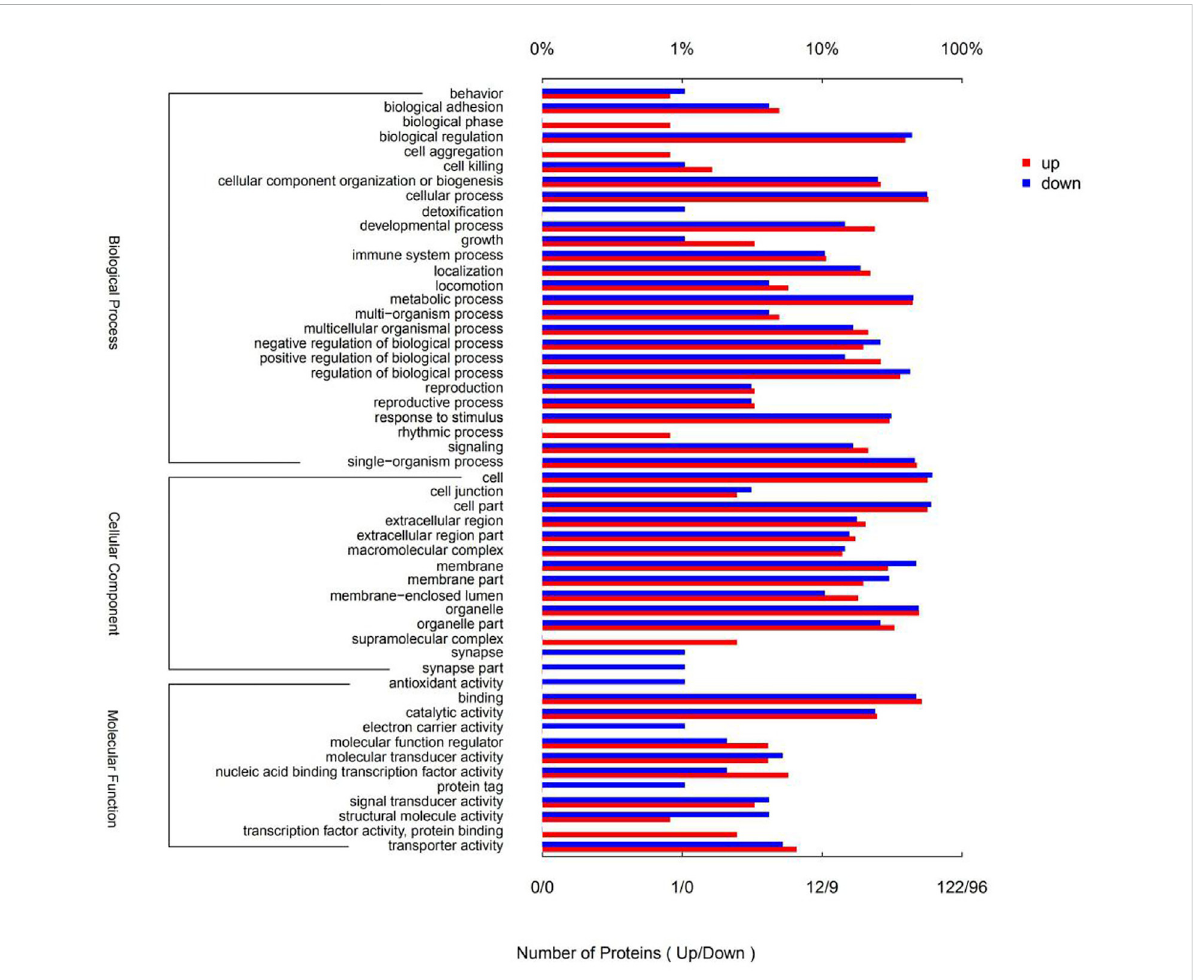
FIGURE 6 GOtermsoftheDSEPsintheartemisinintreatmentgroupcomparedwiththecontrolgroup.Theredbarsrepresentup-regulatedproteins,and the blue bars represent down-regulated